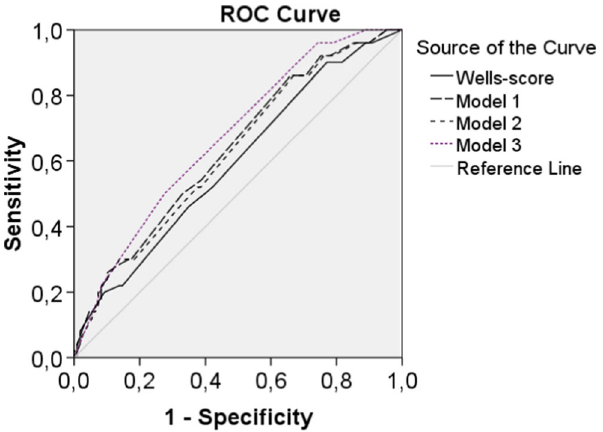
Fig. 1 Diagnostic accuracy of Wells score and